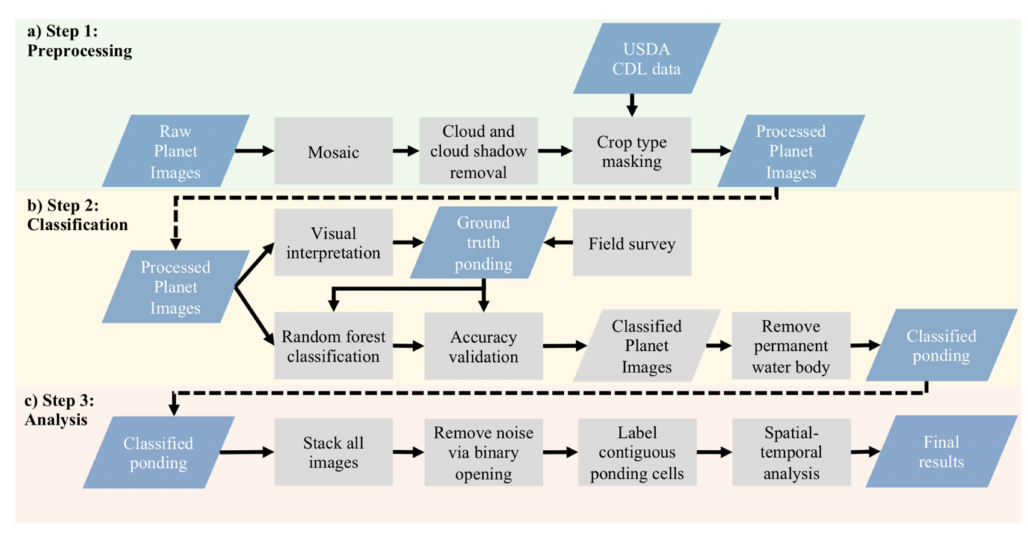
Figure 2. Flowchart of proposed method. ( a ) The initial pre-processing steps are performed mostly in Google Earth Engine to facilitate the generation of mosaicked, masked images with matching extents. ( b ) Random Forest classifications are performed on each mosaicked raster. ( c ) The classified images are combined and analyzed for their spatiotemporal